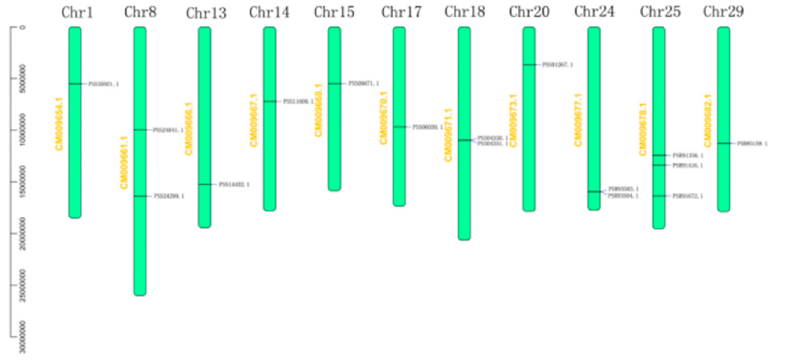
Figure 3. Localization of the BAM genes in A. chinensis genome. Chromosome number is dictated on the chromosome. Table 2. The basic information of the AcBAM gene family.